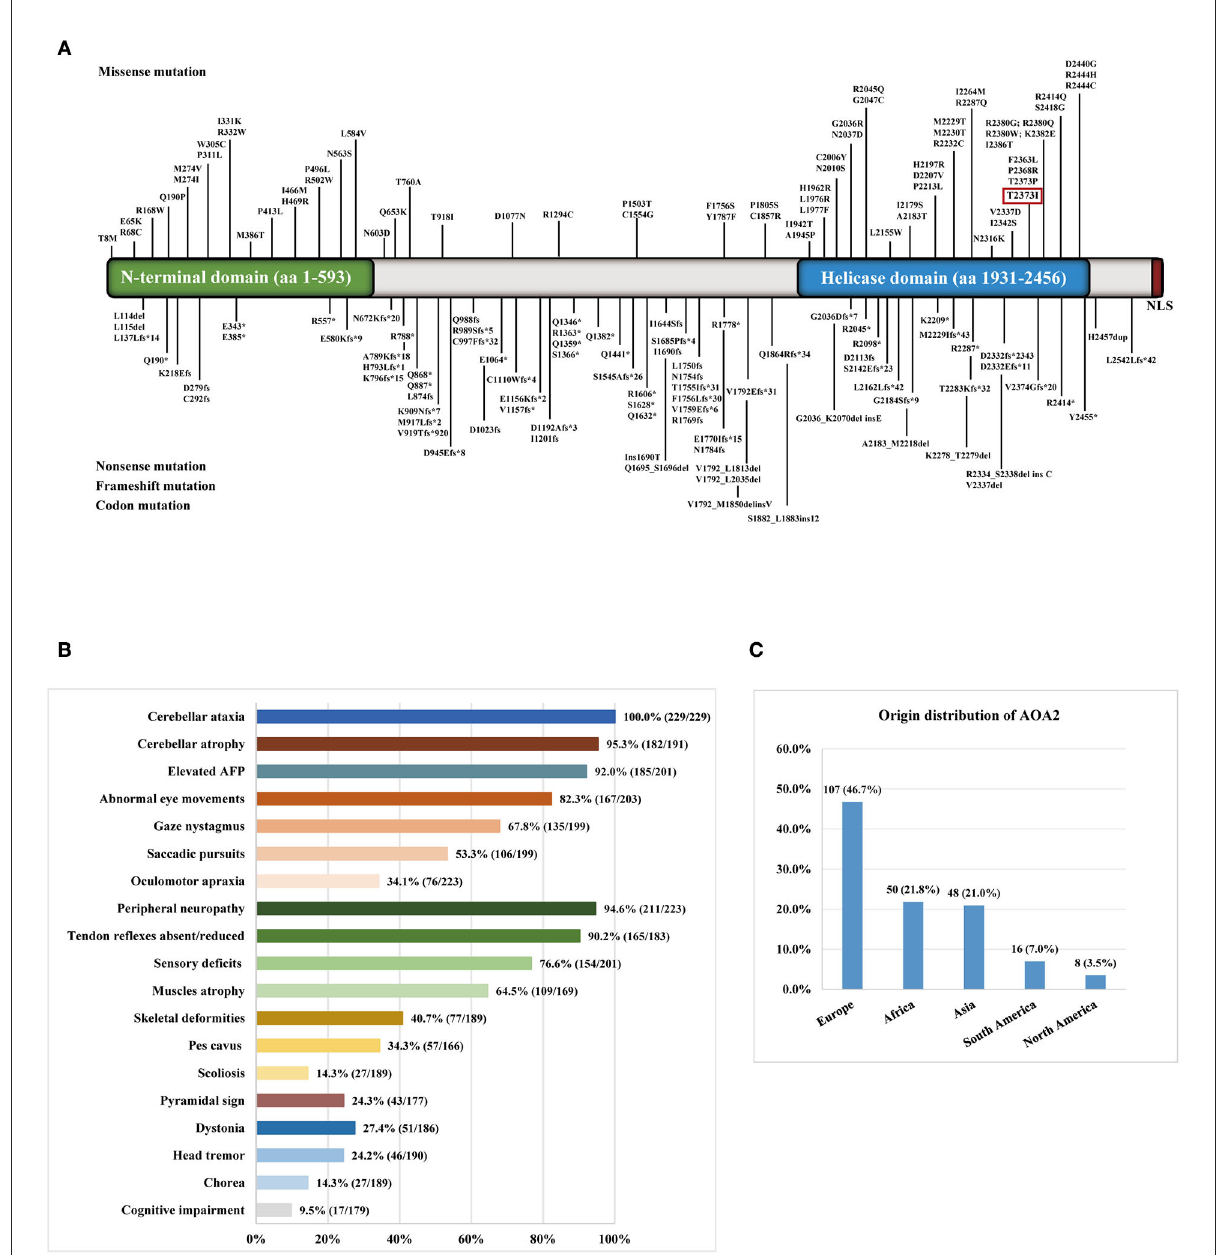
FIGURE2 (A) Distribution of SETX gene variants in ataxia with oculomotor apraxia type 2 (AOA2) patients throughout exons. The variant in the red box was detected in the present study. (B) The clinical symptoms of AOA2 patients with SETX variants. (C) The origin distribution of the AOA2